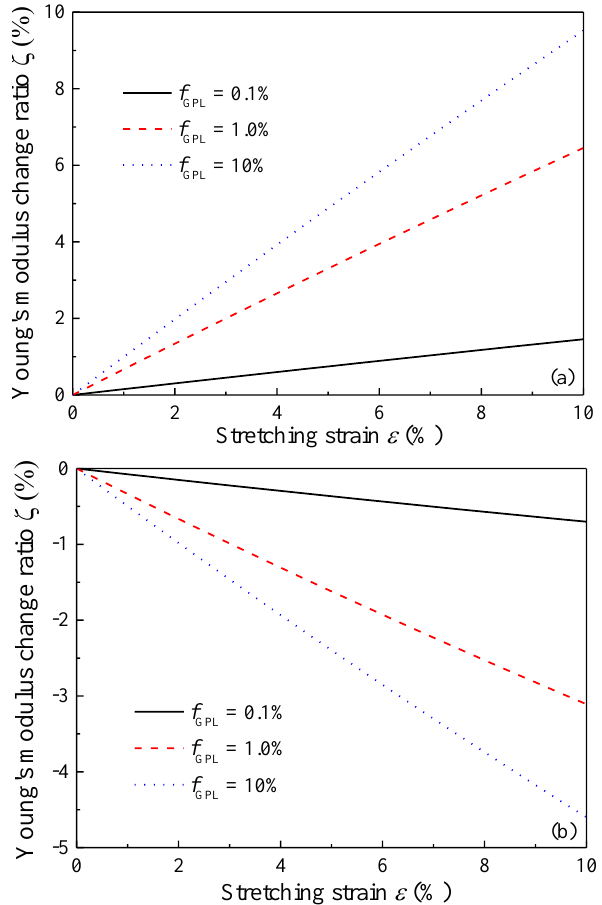
Figure 9. Variation of effective Young’s modulus of GPL/Epoxy nanocomposites with stretching strain ( a ) stretching direction; ( b ) transverse direction.